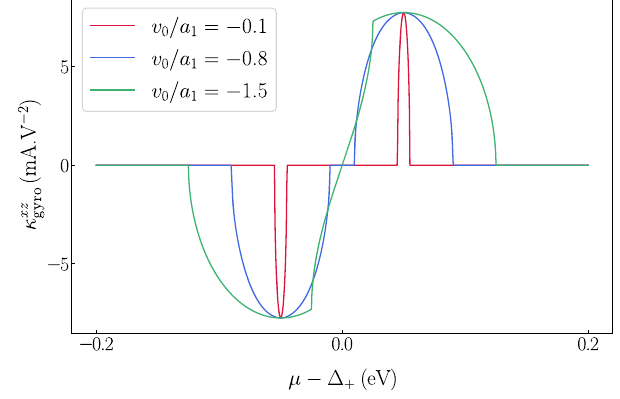
.FIG. 5. Chemical potential dependence of the gyration current coefficient for the frequency of light ℏ Ω ¼ 100 ð meV Þ . Several plotsareshownbychanging v 0 .Theratios v 0 =a 1 ¼ − 0 . 1 , − 0 . 8 ,and − 1 . 5 represent the type-I Dirac (red line), highly tilted type-I Dirac (blue line), and type-II Dirac systems (green line). We introduce Δ ¼ t sin k 0 for the energy shift of the Dirac node s z ¼ ↑ þ